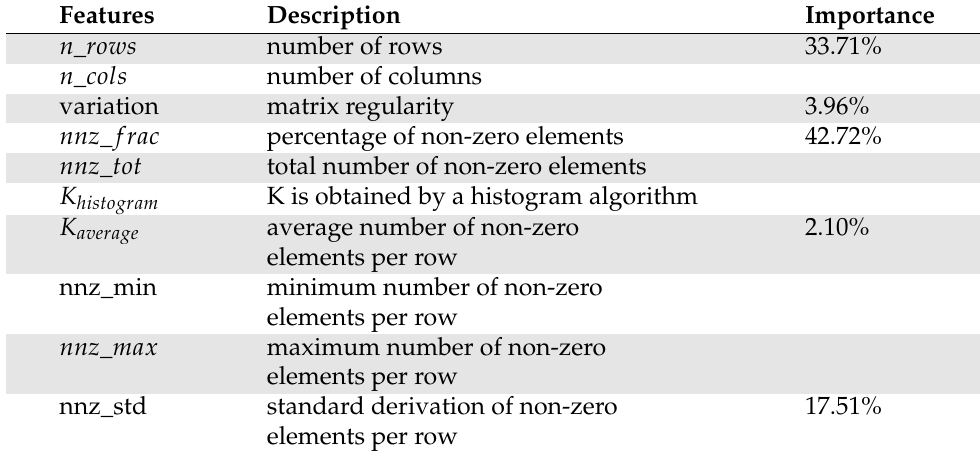
Table 2. Features used in our predictive